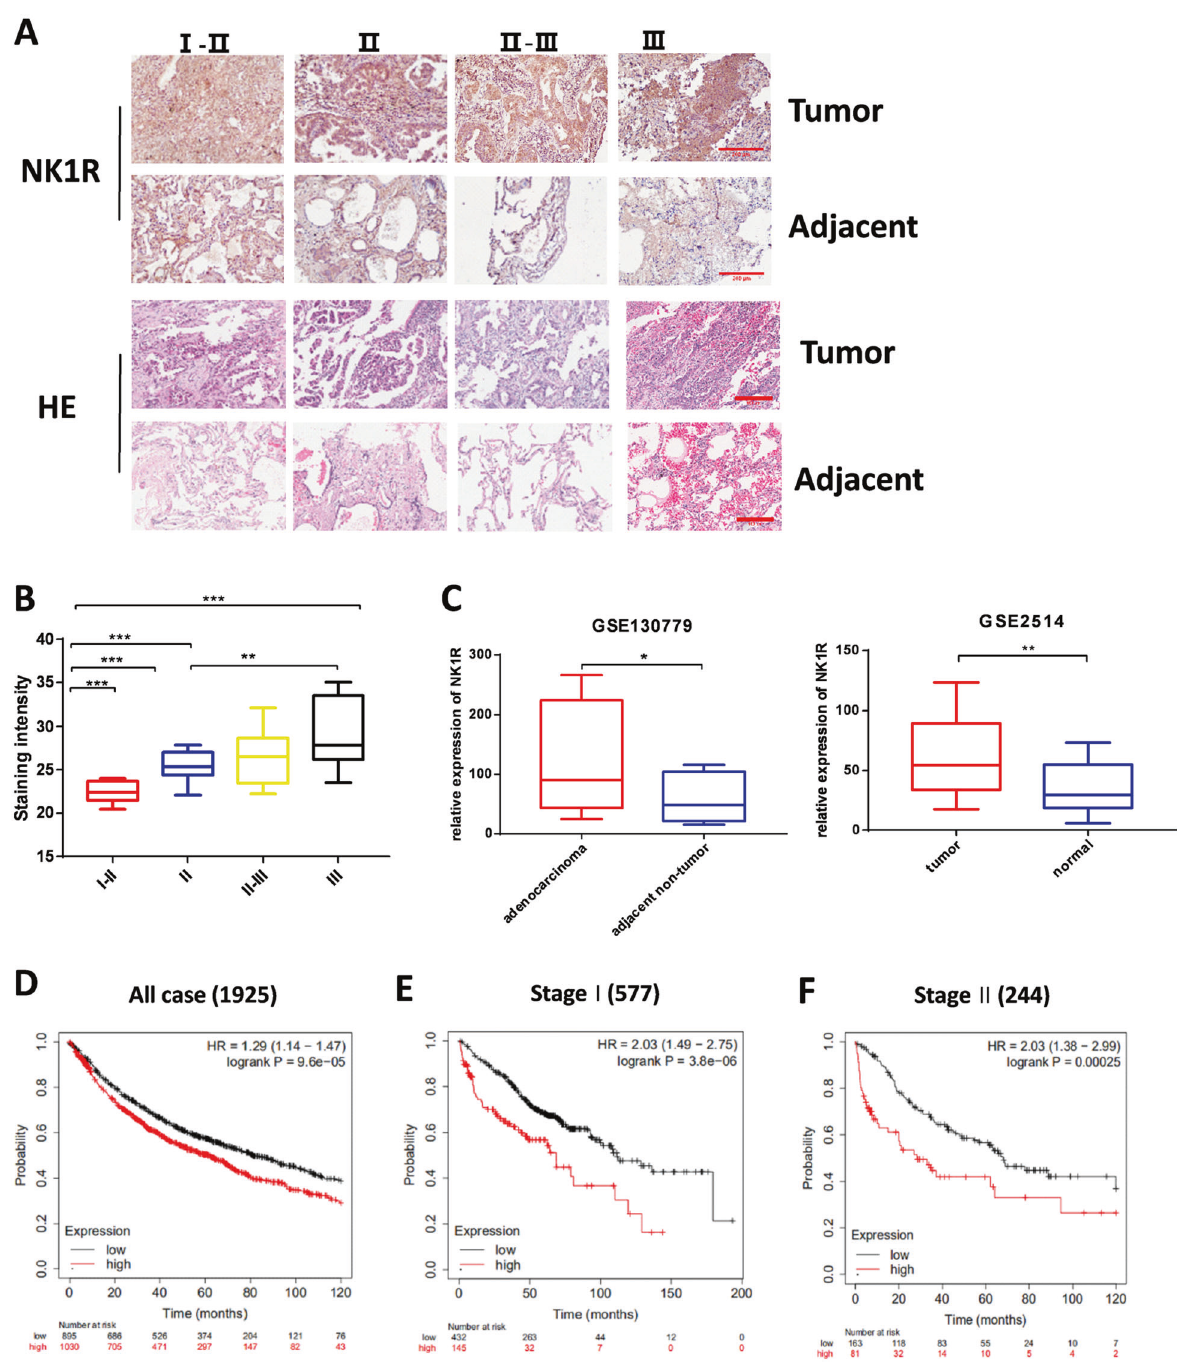
Fig. 1 Expression level of NK1R is related to NSCLC progression and poor prognosis. IHC staining of NK1R was performed on tissue microarrays of 30 human lung adenocarcinoma patients. A The IHC analysis of NK1R expression in tumor tissues compared with matched adjacent tissues from stage I – II ( n = 3), stage II ( n = 11), stage II – III ( n = 13), to stage III ( n = 3). Scale bar, 200 μ m. B IHC staining intensity of NK1R in tumor tissues of lung adenocarcinoma from stage I to stage III. C NK1R expression analysis in human lung cancer in comparison with the matched adjacent tissues in GSE130779 and with normal tissues in GSE2514. D – F The Kaplan – Meier overall survival analysis with the log- rank test in 1925 cases from GEO and TCGA datasets (see details in Methods), de fi ned by tumor stages and by low/high NK1R expression. * P < 0.05, ** P < 0.01, *** P < 0.001. peptide agonist of NK1R [8, 10]. It was observed that hHK-1 induced result of FACS analysis indicated that NK1R was obviously detected on signi fi cant phosphorylation of ERK1/2 and Akt in a time-dependent cell membrane of NCI-H1944, NCI-H1975, NCI-H226, A549, and way while the selective antagonist of NK1R aprepitant inhibited the relatively lower in HCC827 (Fig. 2C). To determine whether NK1R effect dose-dependently (Fig. 2D, E and Supplementary Fig. 2). NK1R- functioned in NSCLC cells, we evaluated the in fl uence of NK1R on mediated MAPK and Akt signaling pathways have been involved with intracellular signaling in different NSCLC cells. hHK-1 is an endogenous